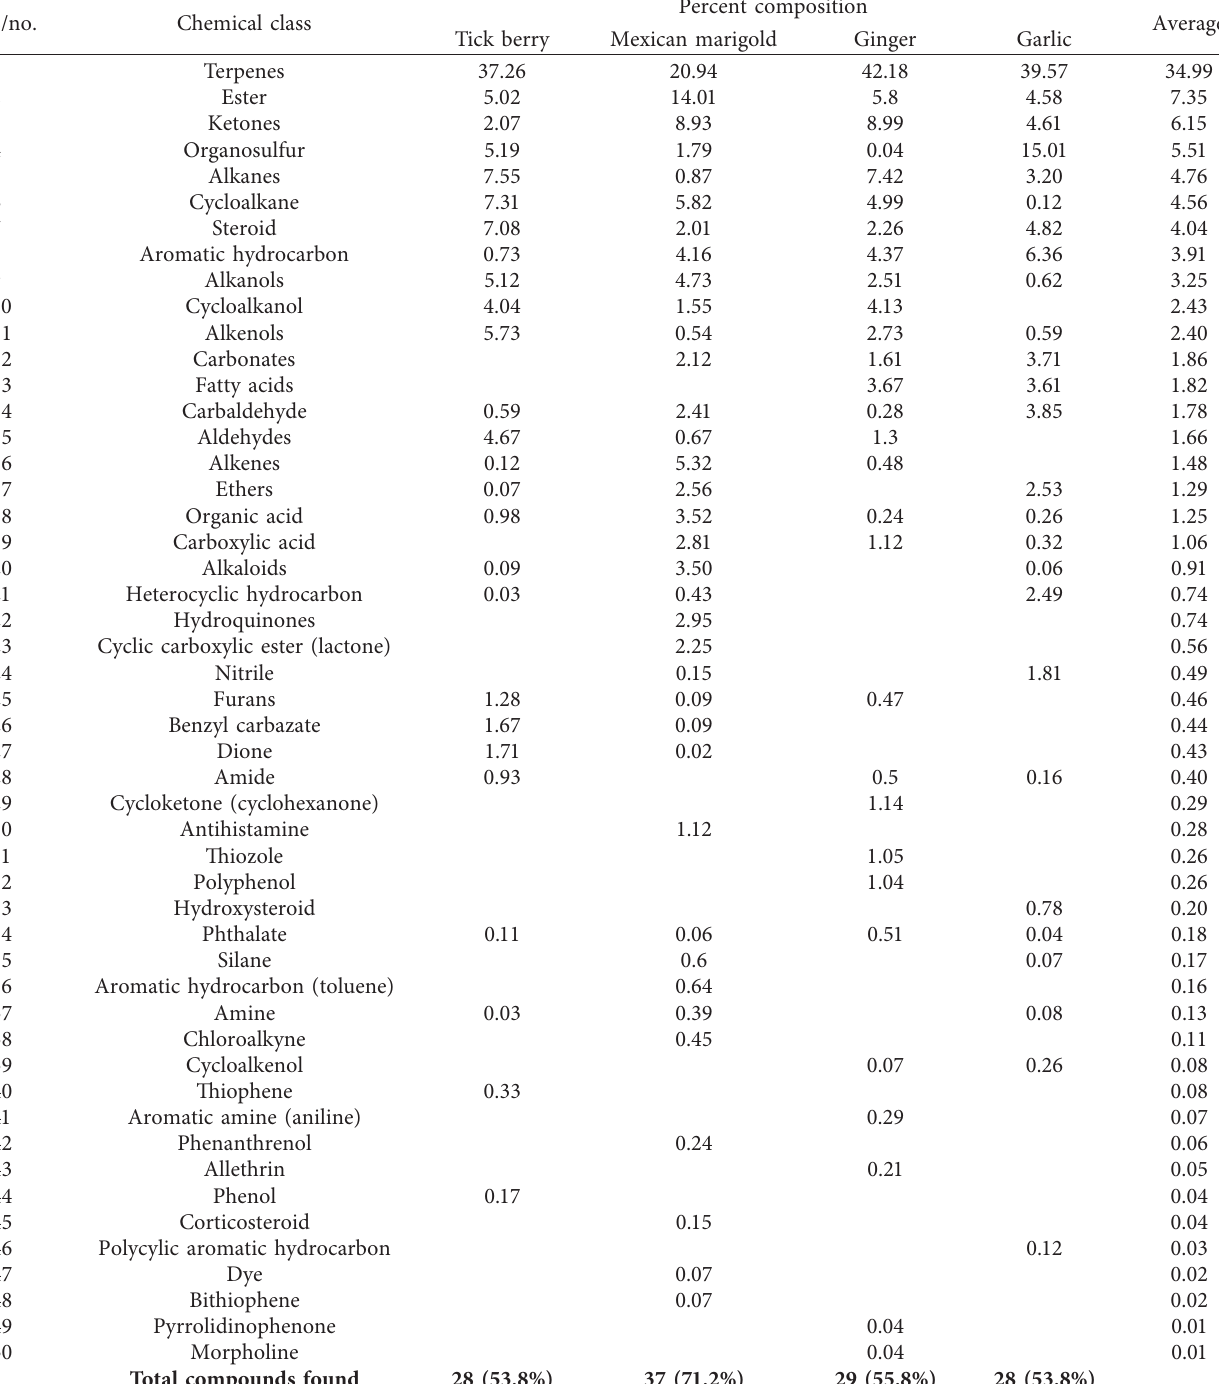
Table 1: Composition of chemical classes identified from different essential oils.